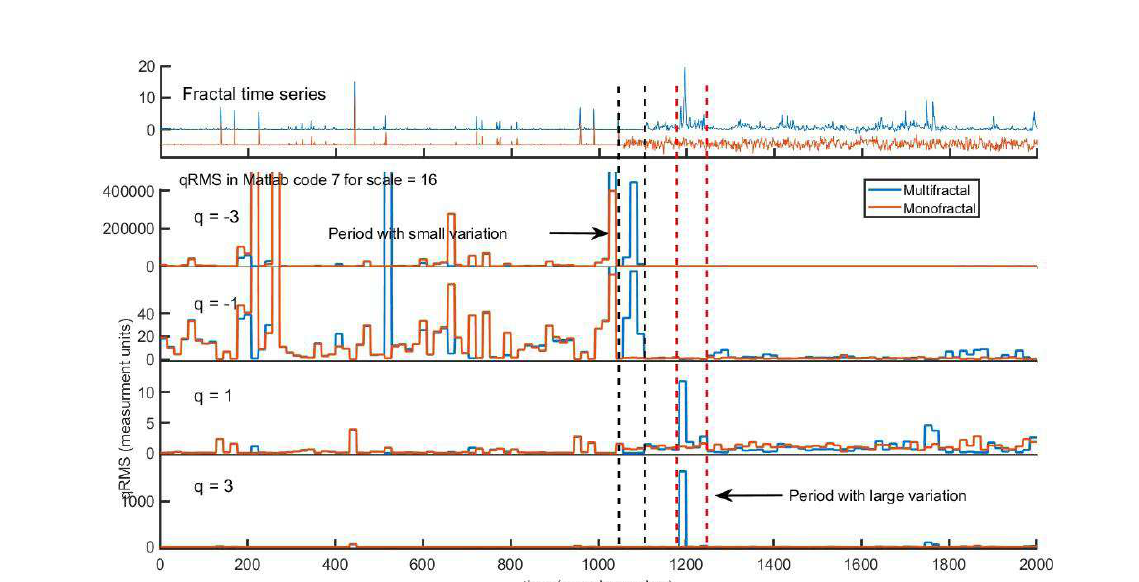
Figure 5. q th -order RMS for different time